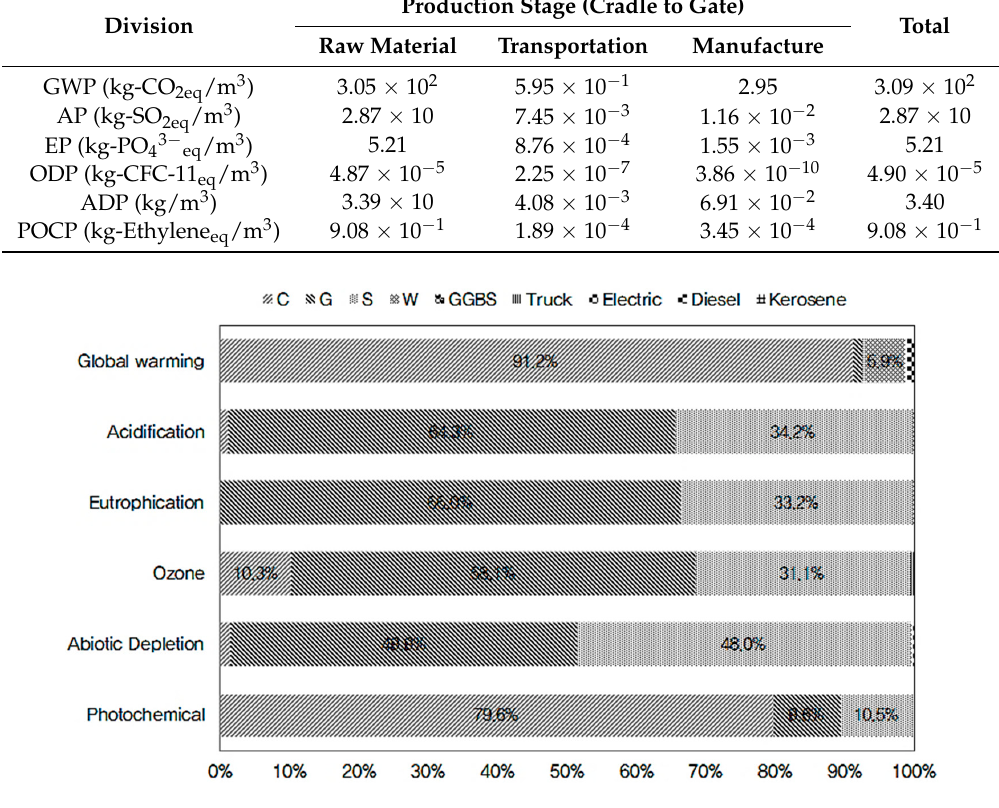
Figure 4. Environmental Impact Assessment Result by concrete LCA.